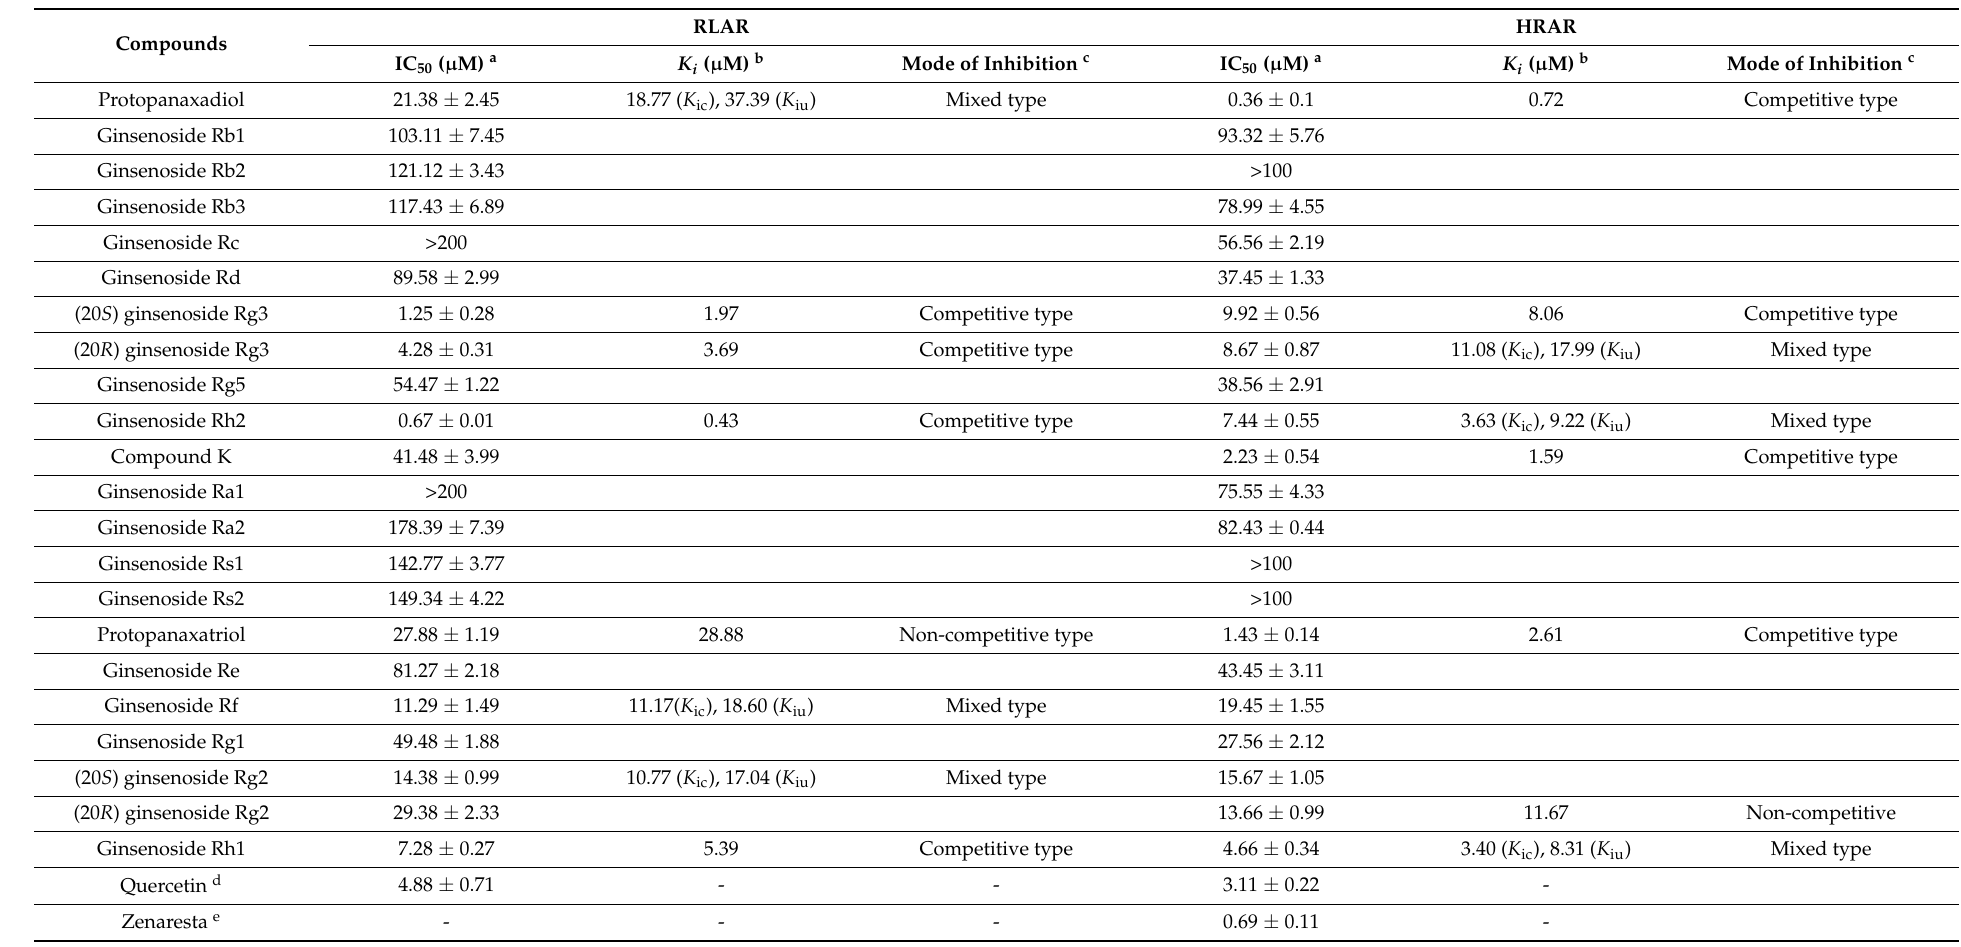
Table 1. The in vitro inhibitory activities of ginsenosides on RLAR and